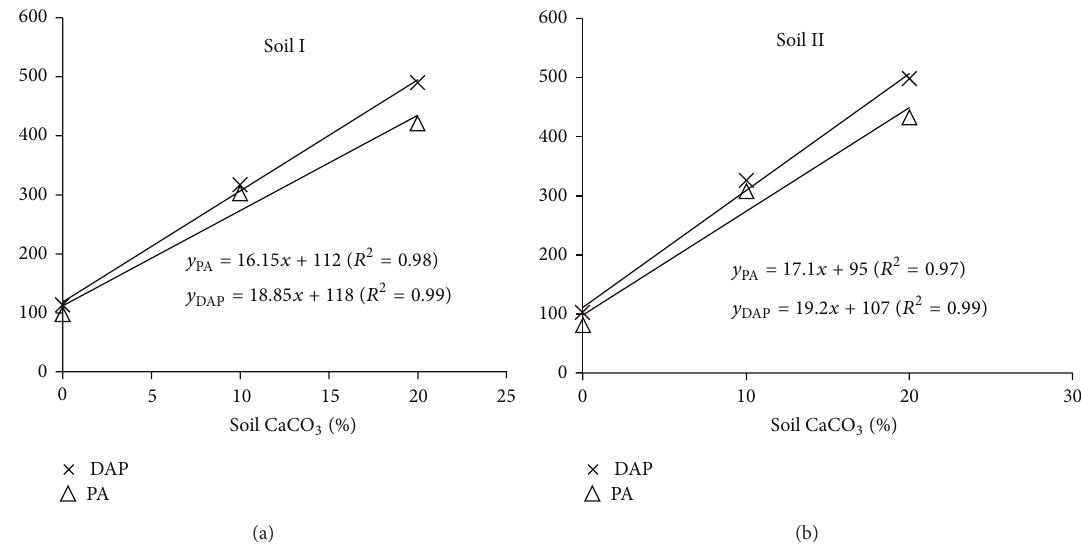
Figure 2: Relationship between soil CaCO 3 and P 2 O 5 requirement (kgha −1 ) to achieve 0.2 mg L −1 soil solution P.